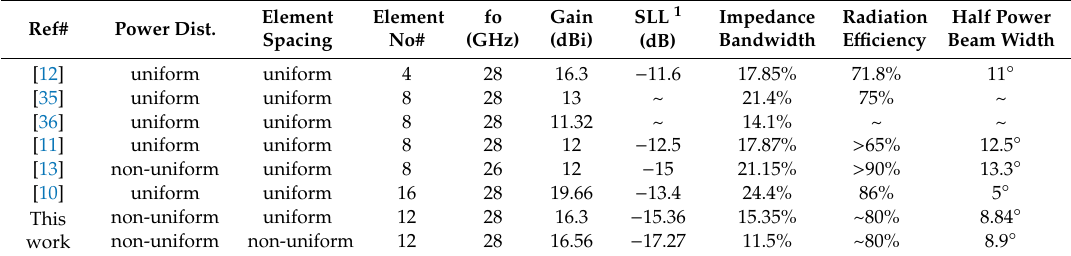
Table 4. Performance comparison of the antenna arrays, fed by the microstrip-based power divider, operating near 28 GHz for 5G